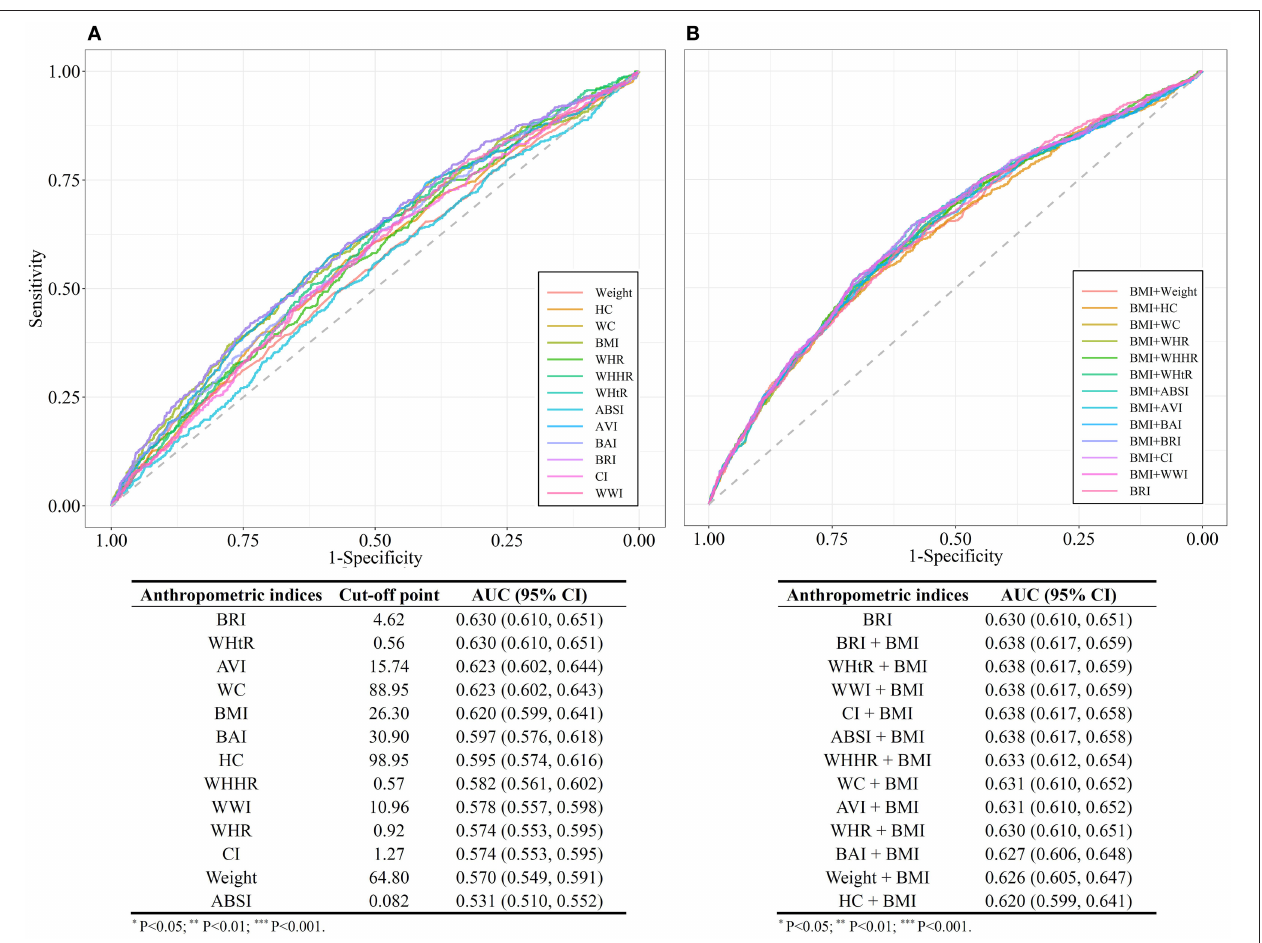
FIGURE 5 | (A) Comparison of the receiver operating characteristic (ROC) curves for separate anthropometric indices (body mass index [BMI], waist circumference [WC], waist-to-hip ratio [WHR], waist-to-height ratio [WHtR], a body shape index [ABSI], abdominal volume index [AVI], body adiposity index [BAI], body